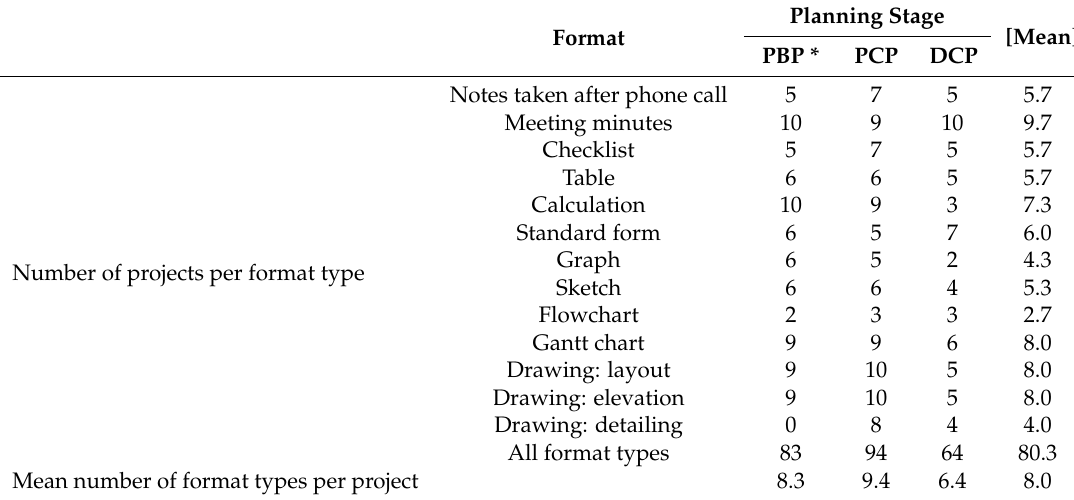
Table 5. Formats of